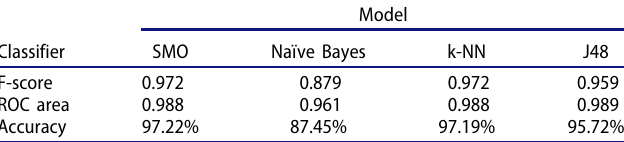
Table 4. Average of the statistical measures of the models by